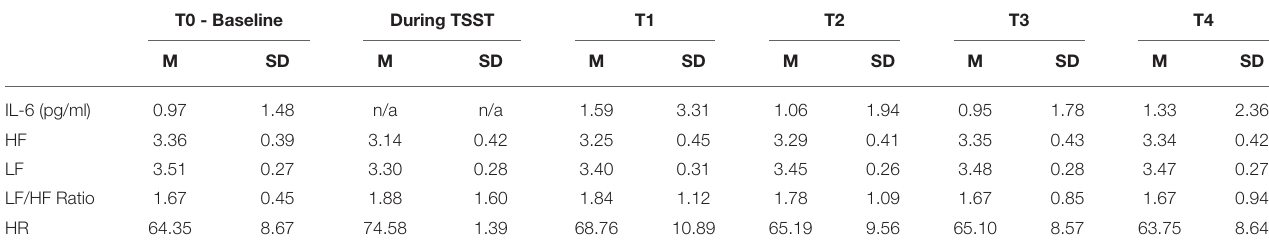
TABLE 1 | Descriptive data for salivary IL-6 and indices of heart rate variability ( N =